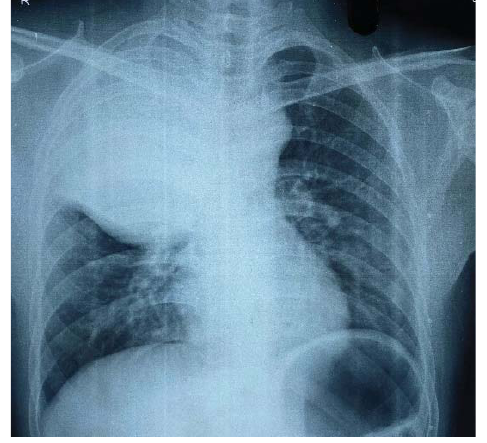
Figure 1. Chest X-ray Figure 2. CECT Chest